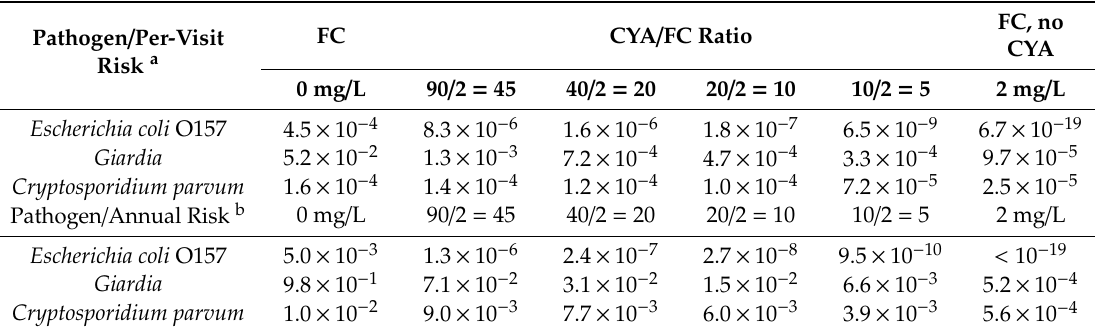
Table 7. Probability of